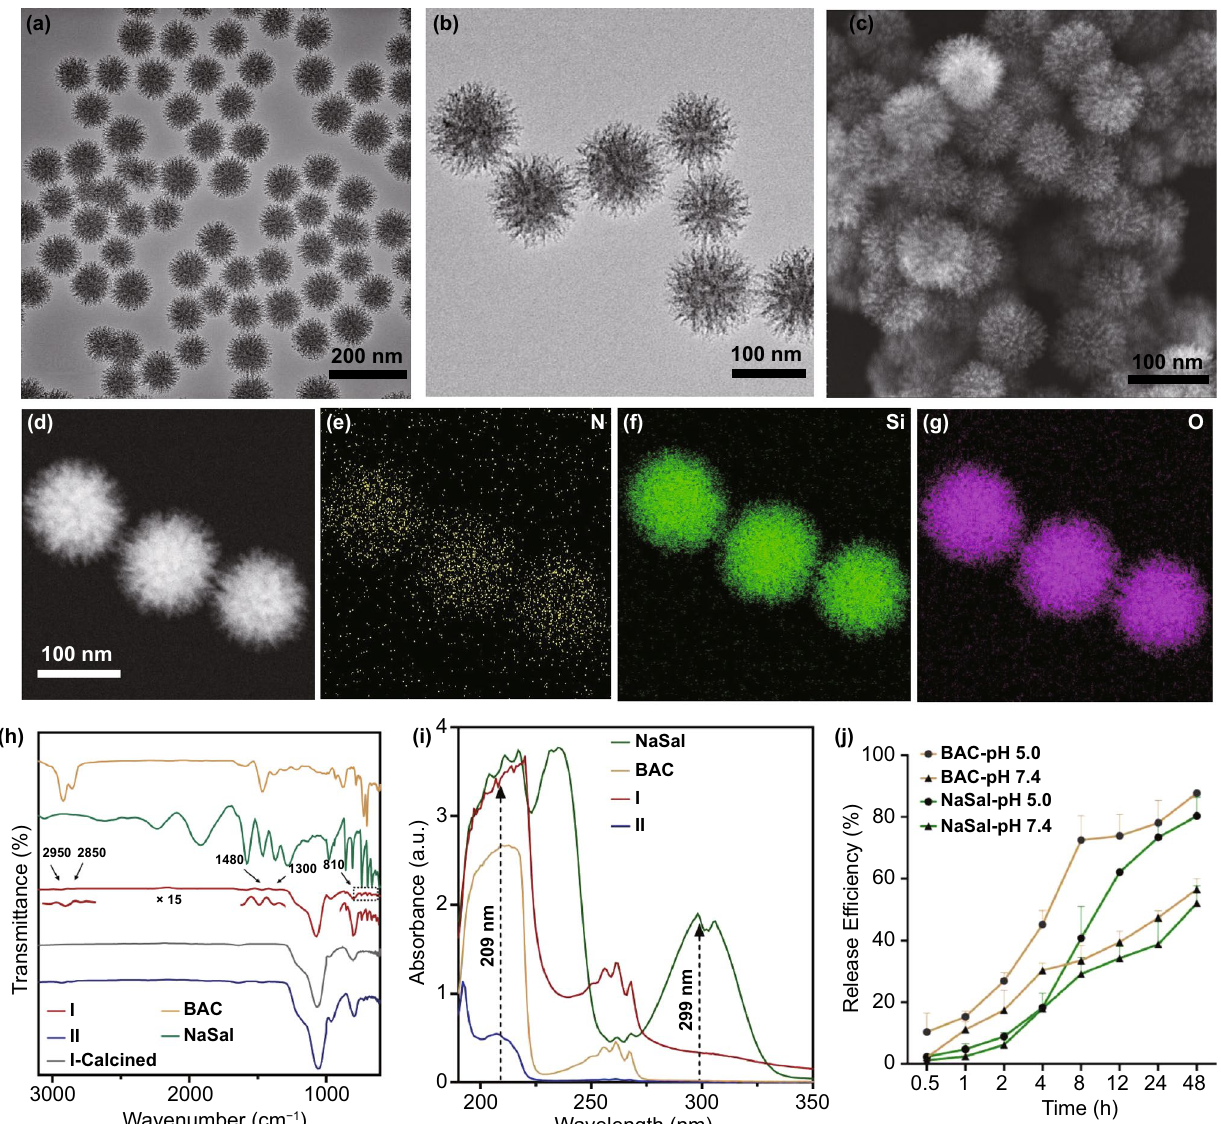
Fig. 1 a , b TEM, c SEM and d – g EDX mapping images of nanocomposite I . h FTIR spectra of nanocomposites I and II , calcined nanocompos- ite I , BAC and NaSal. I . i UV–Vis spectra of nanocomposites I and II. j Time-dependent release profile of BAC and NaSal from nanocomposite I at pH 7.4 and